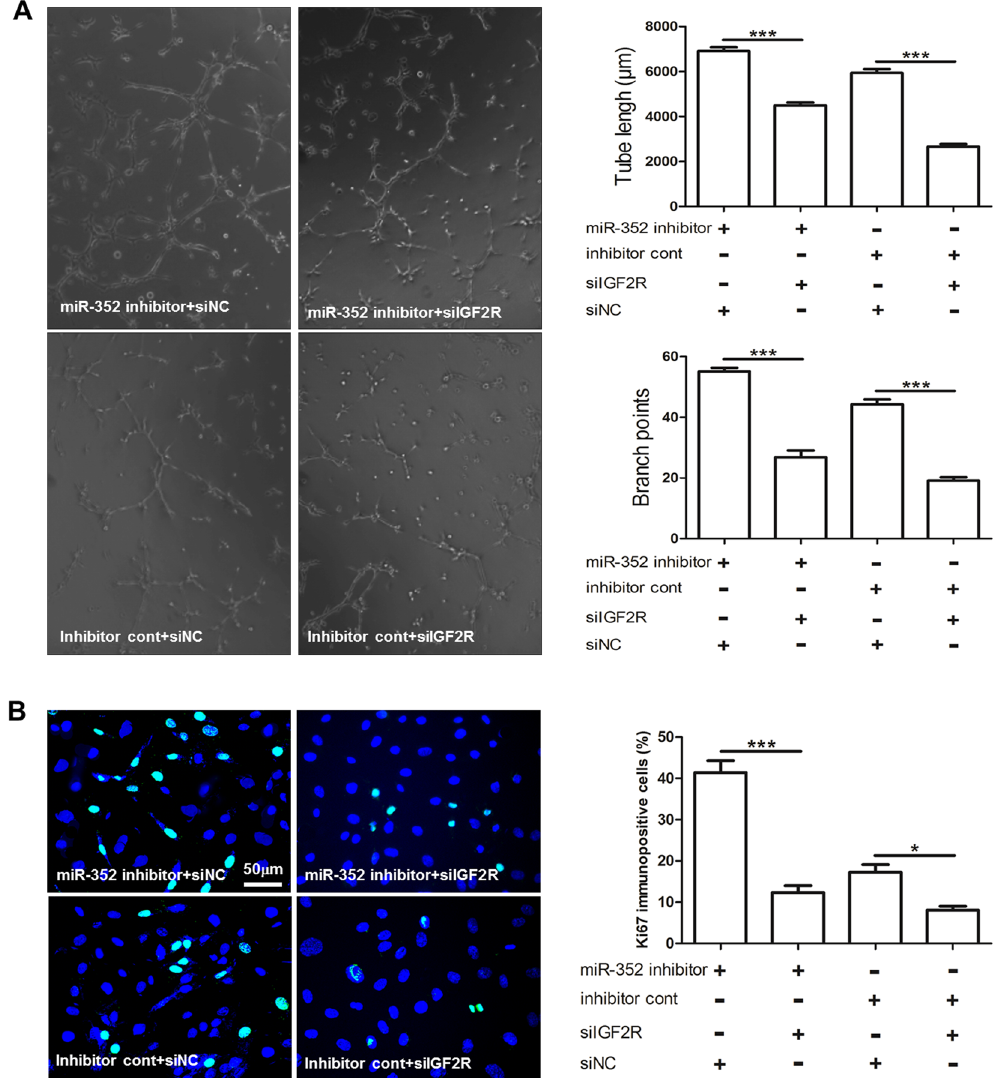
Figure 5. miR-352 regulates endothelial tube formation and cell proliferation in cultured RAECs by targeting the IGF2R gene. ( A ) Effect of miR-352 inhibitor + siIGF2R (IGF2R siRNA); miR-352 inhibitor + siNC (a scrambled siRNA); siIGF2R + inhibitor cont; or siNC + inhibitor cont on endothelial tube formation ( *** P < 0.001, n = 3). ( B ) Effect of the miR-352 inhibitor + siIGF2R (IGF2R siRNA); miR-352 inhibitor + siNC (a scrambled siRNA); siIGF2R + inhibitor cont or siNC + inhibitor cont on RAEC proliferation was detected by Ki67 immunofluorescence. Specific fluorescence in green, and nuclei are labelled in blue. Notably, treatment with miR- 352 inhibitor + siIGF2R or inhibitor cont + siIGF2R significantly reduced both endothelial tube formation and cell proliferation in cultured RAECs as compared to treatment with miR-352 inhibitor + siNC or inhibitor + siNC, respectively, indicating that IGF2R is a miR-352 target in RAECs ( *** P < 0.001, * P < 0.05, n =